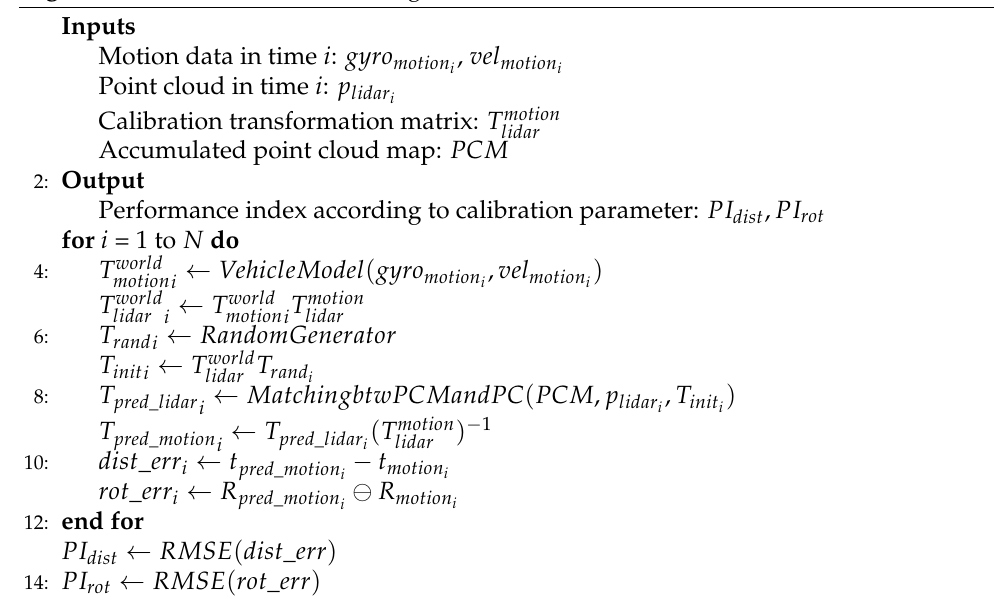
Algorithm 2 Evaluation of Matching